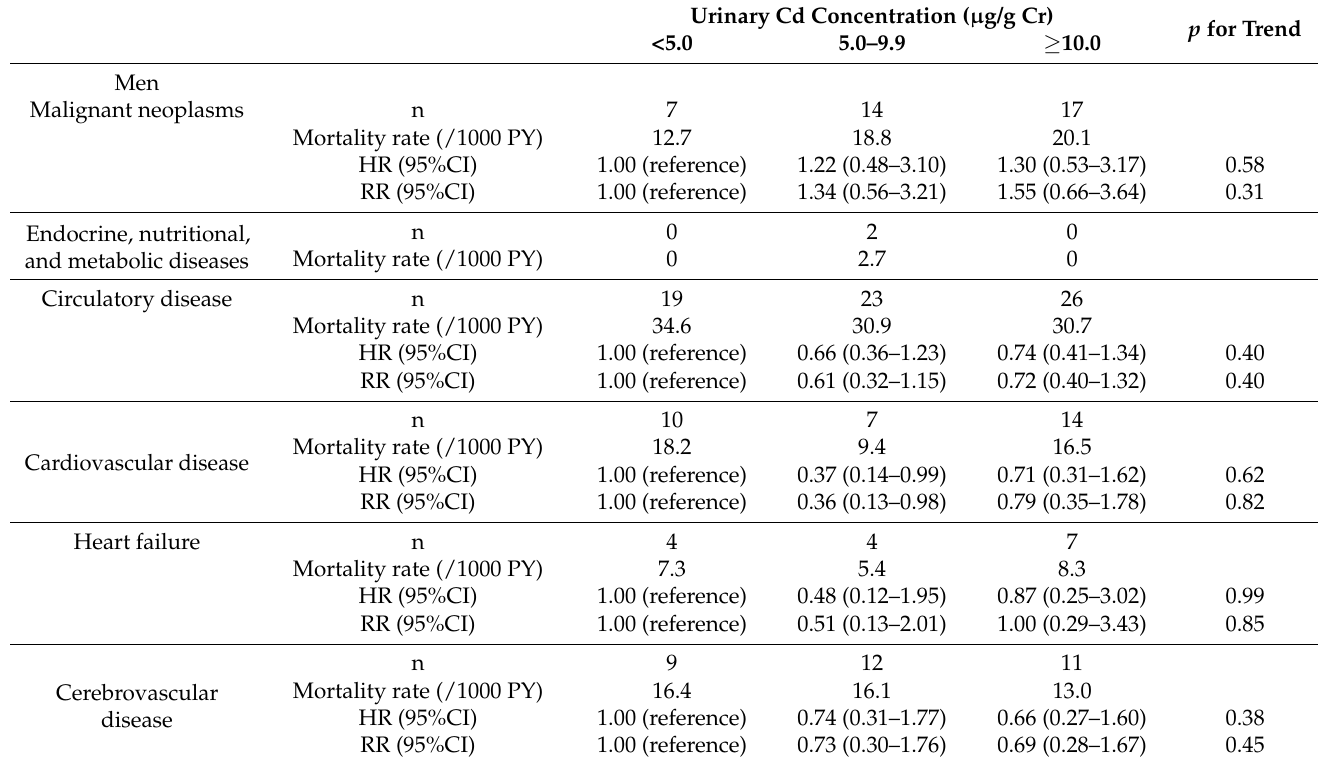
Table 6. Risks of cause-specific mortality according to the urinary Cd concentration in the participants with a urinary β 2-MG level of 1000 µ g/g Cr or